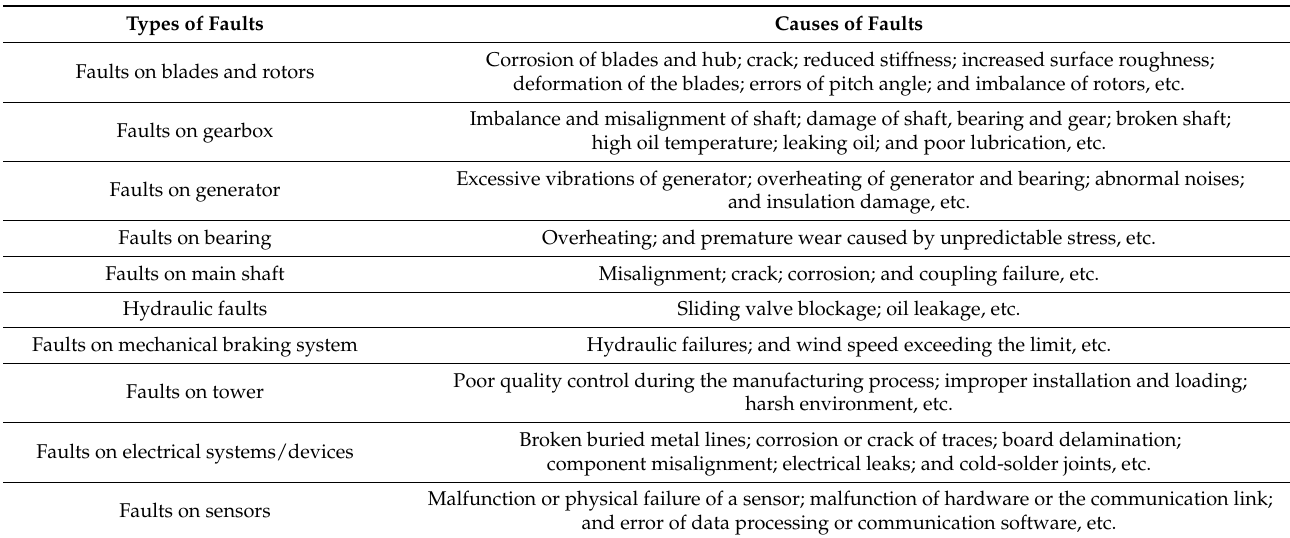
Figure 2. Percentages of typical faults in wind turbines [26]. Table 2. Typical faults in wind turbines [1,14,18].